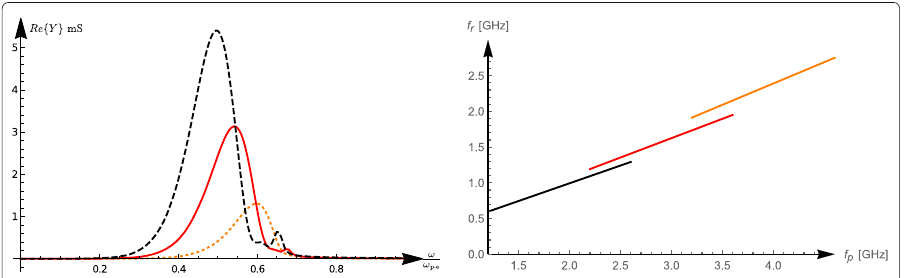
frequencies (right) for different probe radii: R S = 2mm (dotted orange line), R S = 3mm (bold red line), and R S = 4mm (dashed black